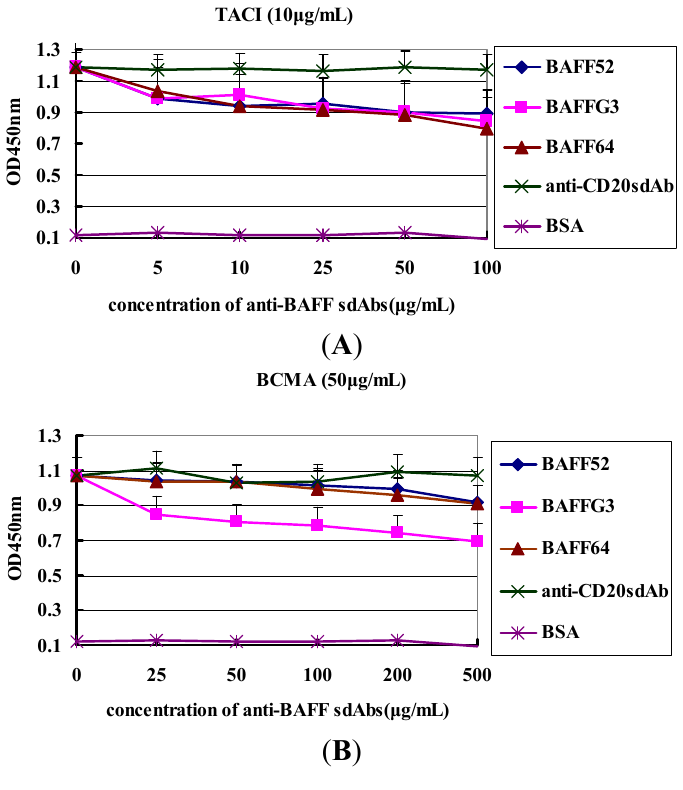
Figure 3. Competitive binding of VHHs for TACI (transmembrane activator and calcium modulator ligand interactor) and BCMA (B cell maturation antigen). Competitive enzyme-linked immunosorbent assay (ELISA) was used to assess competition across a range of concentrations. ( A ) Inhibition of TACI by sdAbs; ( B ) Inhibition of BCMA by sdAbs. Anti-CD20 sdAb was the negative control.